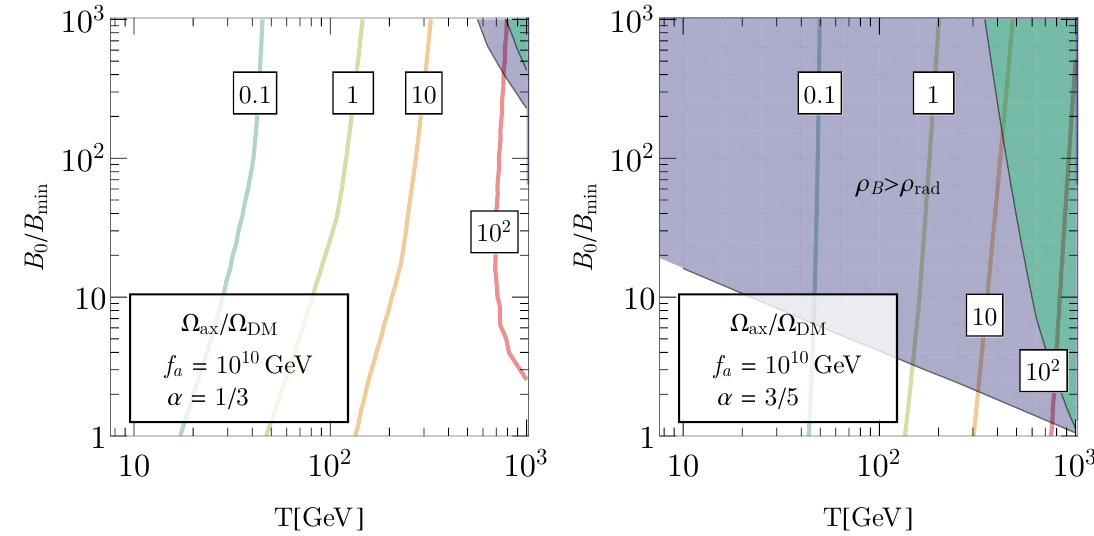
Figure 7 . Ω ax / Ω DM as a function of T init and B 0 today, scaled by the observed lower bound B min ≡ 1 · 10 − 13 G. The contours are labeled by the value of Ω ax / Ω DM . f a is taken to be 10 10 GeV. Left : α = 1 / 3 , Right : α = 3 / 5 . The purple shaded region in the left panel is excluded by the back reaction of the current on the PMF. The purple shaded region in the right panel is excluded by the PMF dominating the evolution of the universe. The green regions indicate Ω y (cid:29) 10 − 15 , these vortons decay away before dominating the universe.